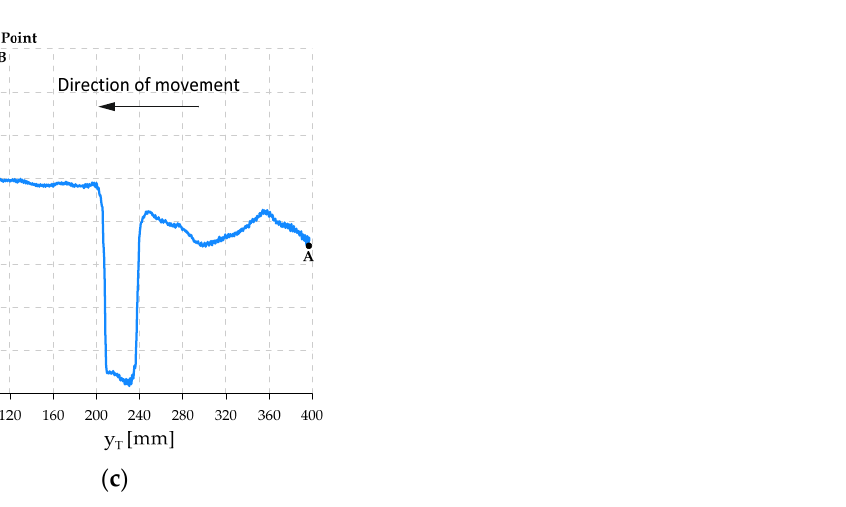
Figure 9. Graphs of the completed motion path, divided into 3 phases: ( a ) Motion phase No. 1 from point A to B, for the range (cid:4670)𝑡 (cid:2869)(cid:3046) , 𝑡 (cid:2869)(cid:3038) ) ; ( b ) motion phase No. 2 from point B to A, for the range (cid:4670)𝑡 (cid:2870)(cid:3046) , 𝑡 (cid:2870)(cid:3038) ) ; ( c ) motion phase No. 3 from point A to B, for the range (cid:4670)𝑡 (cid:2871)(cid:3046) ,𝑡 (cid:2871)(cid:3038) (cid:4671) .